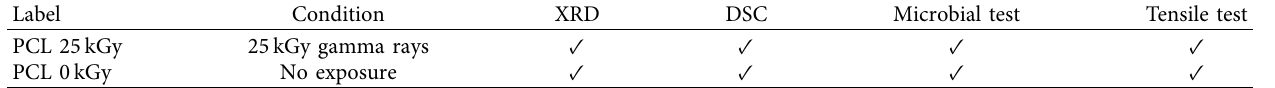
Table 1: Sample experimental conditions and conducted experiments.